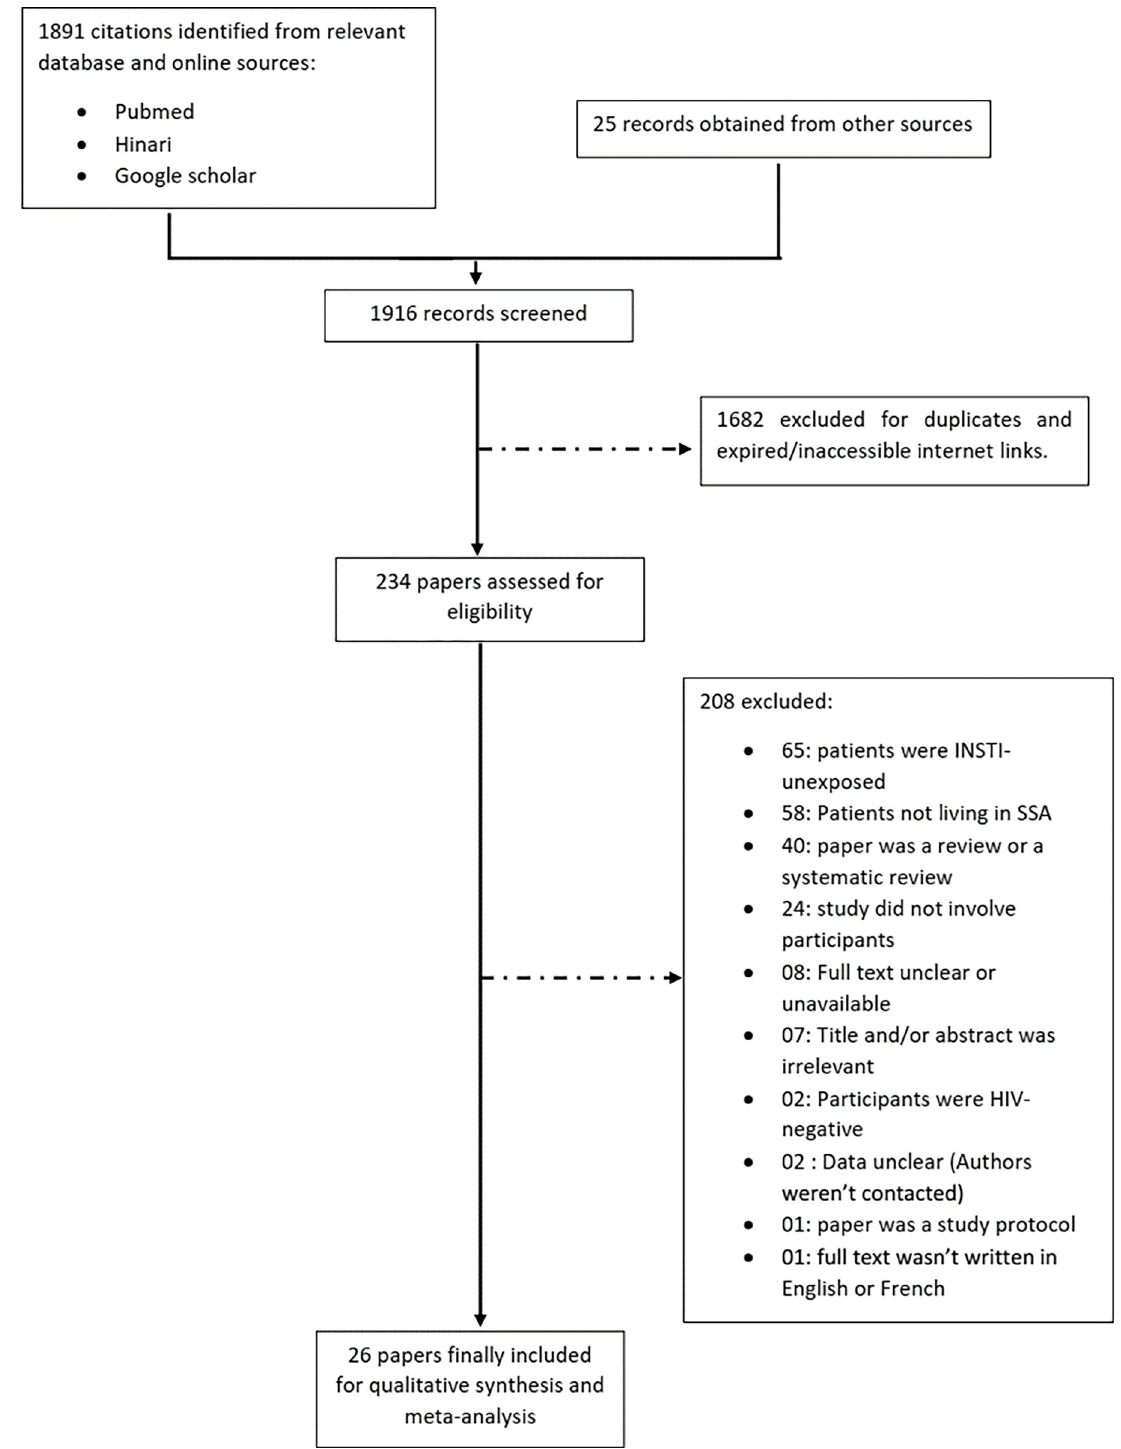
Fig 1. List of papers excluded from the systematic review and meta-analysis; interrupted lines represent excluded studies with reasons for exclusion.